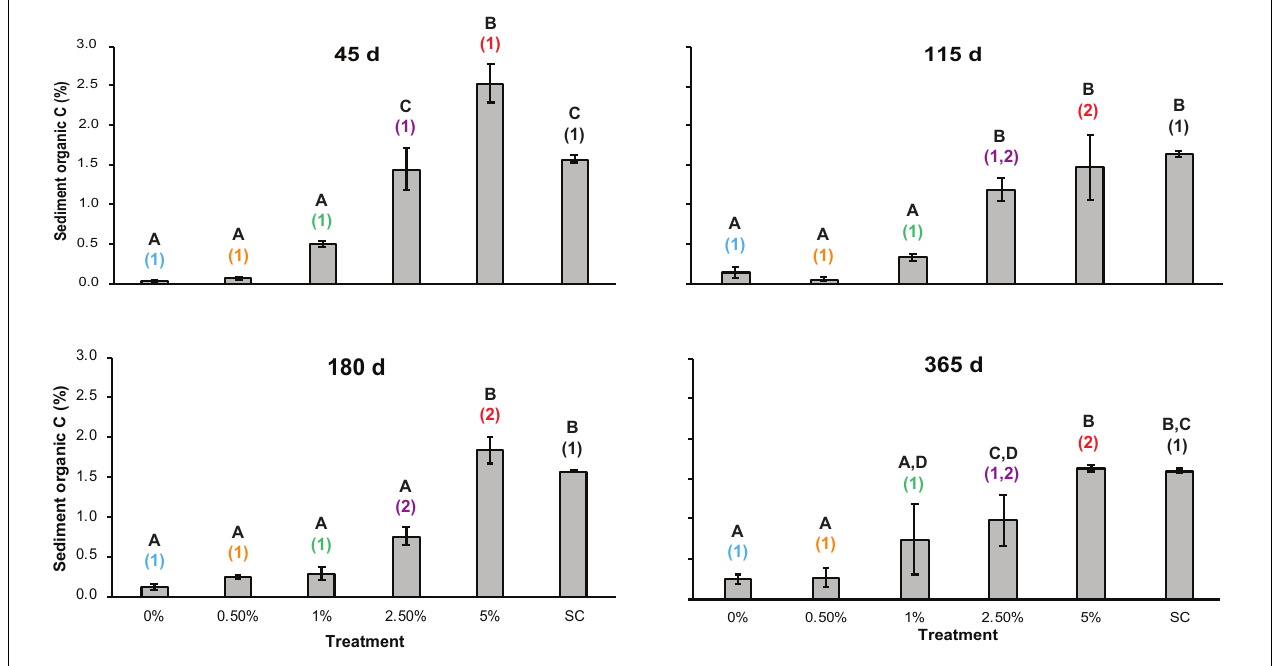
FIGURE 3 | Mean sediment organic C (C org ) content (%) in the different treatments over time. Errors bars denote ± 1 standard error of the mean ( n = 3). Different letters denote significant differences ( p < 0.05) between the means of the treatments at each sampling point. Different colored numbers denote significant differences ( p < 0.05) between the means of a specific treatment at different sampling times. Colors used for the different treatments are the same as in Figure 2 to aid clarity.